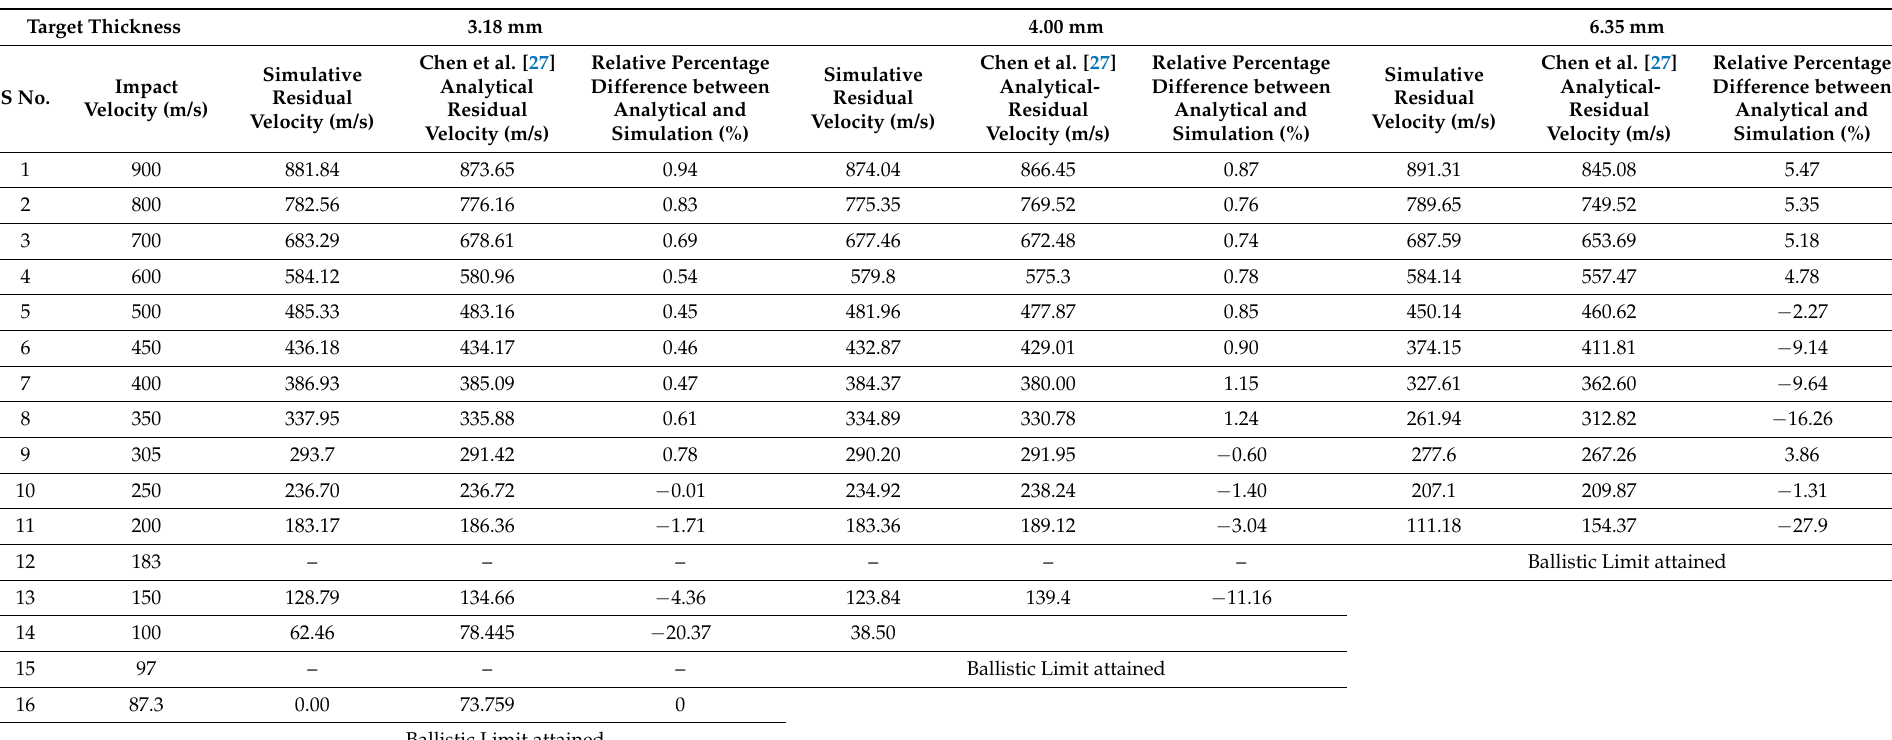
Table 6. Residual velocities obtained from simulations are compared and validated by analytical model for all thicknesses and for various impact velocities for Al 2024-T3 alloy. Target